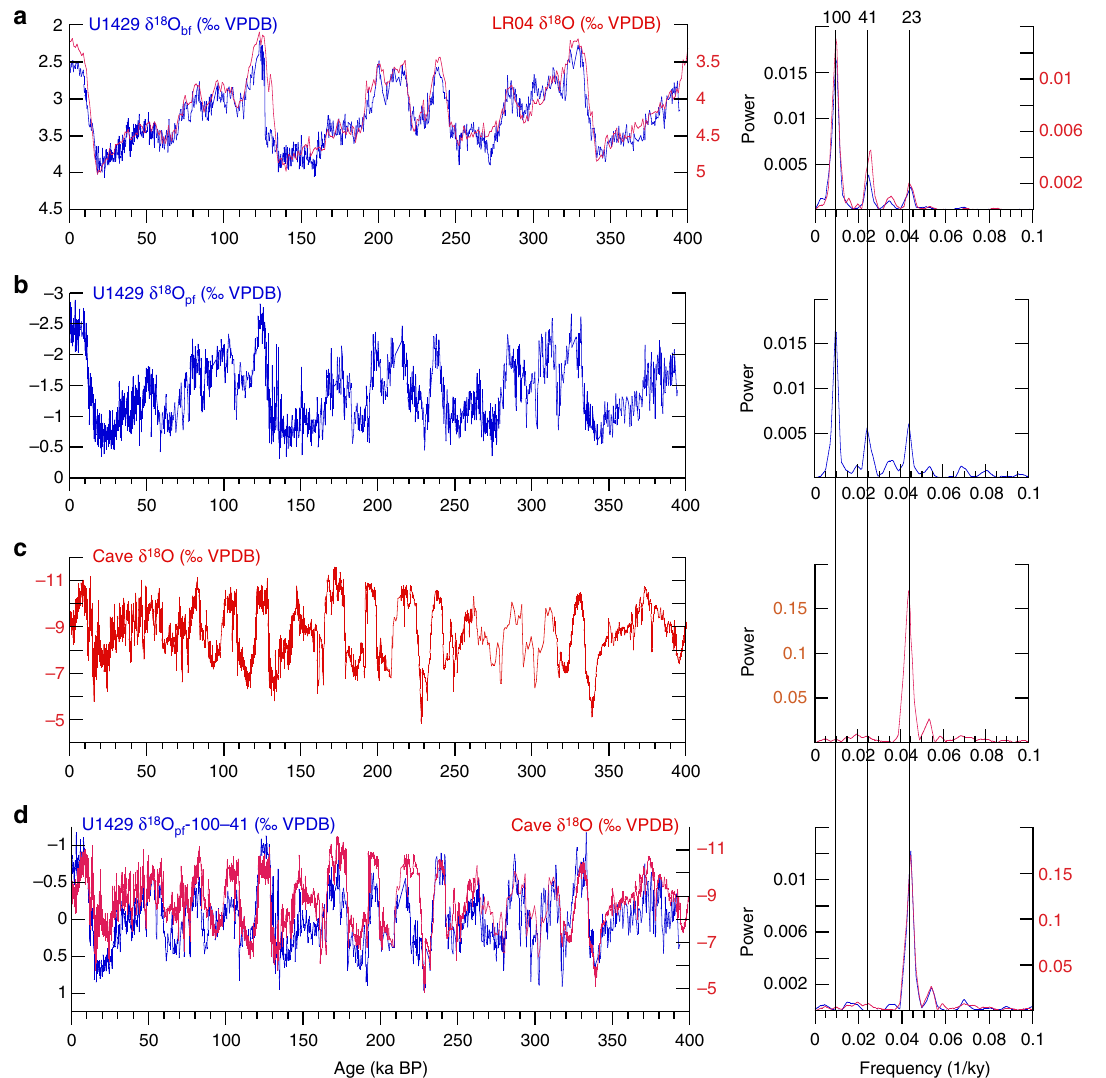
Fig. 2 Proxy time series and spectra. a U1429 δ 18 O bf mapped to the benthic chronology 52 . b U1429 δ 18 O pf on the benthic age model. c δ 18 O cave 15 , d Notched δ 18 O pf mapped to δ 18 O cave . Labeled dashed lines denote primary orbital frequencies (frequency = 1/period in